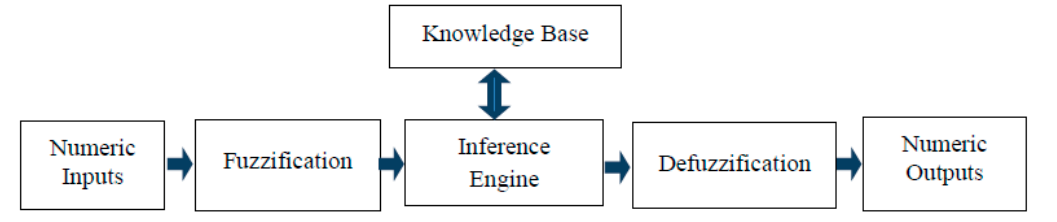
Figure 2. The fuzzy inference system.